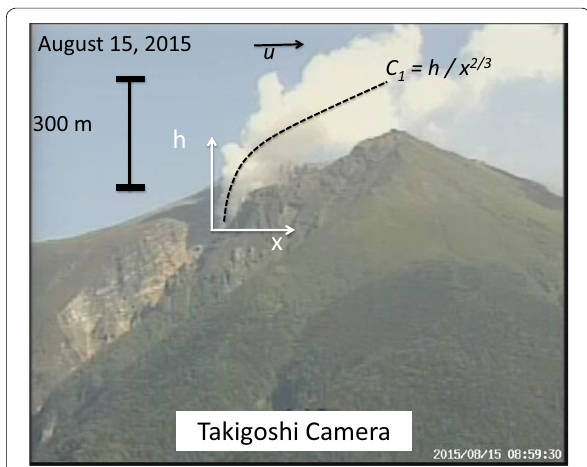
Fig. 3 An example photograph of plumes viewed from Takigoshi station taken on 15 August 2015. The photos were provided from JMA. By tracking of movements of the identical portion of the plume over consecutive images, we estimated wind velocity u and coefficient of the plume shape C 1 , in a local coordinate of x , horizontal distance from a reference point, and h , which is vertical distance from a reference point, and then plume heat flux ˙ Q h (see text for the detail of analysis procedure)